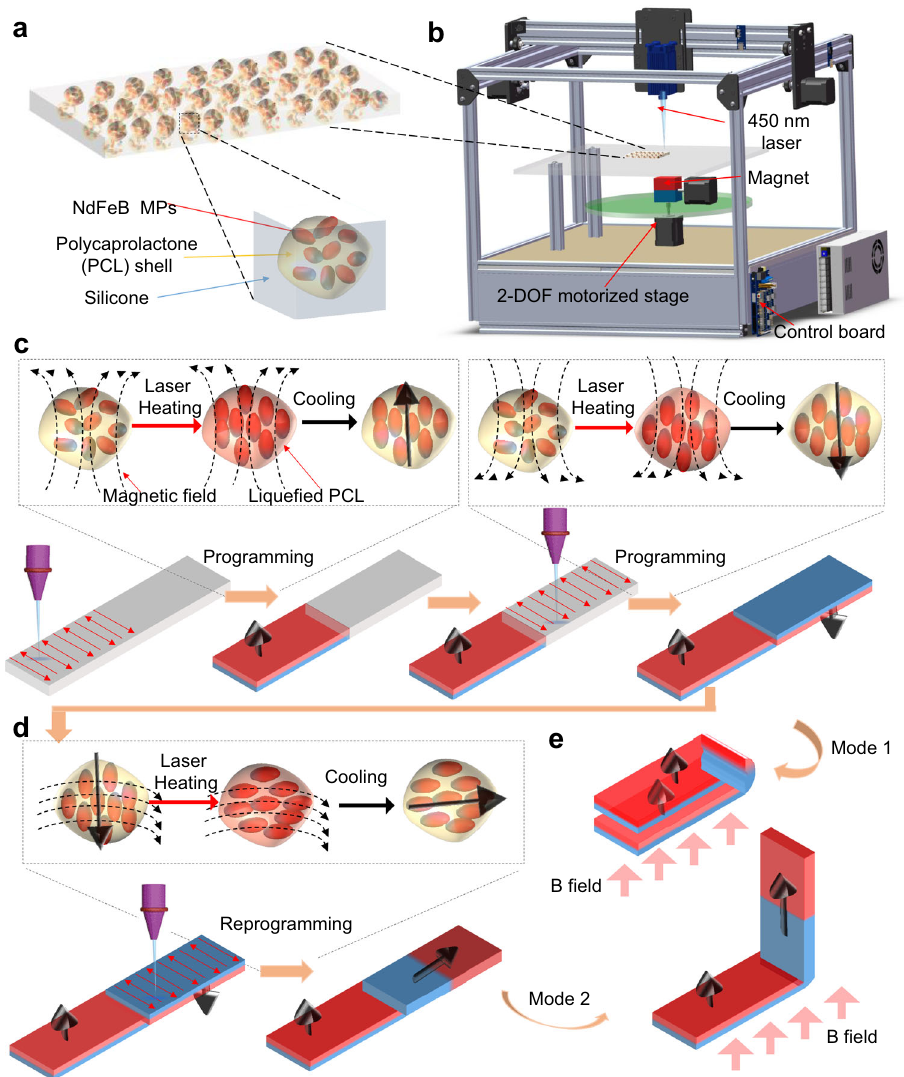
Fig. 1 System design and mechanism of reprogramming the magnetic anisotropy in MRSM fi lms by DLW. a Schematic showing the structure of a MRSM fi lm, which consists of silicone and magnetic NdFeB MPs wrapped by PCL shells. b Schematic of a customized DLW system for programming a magnetic anisotropy in a MRSM fi lm. c Schematic showing steps of programming a magnetic anisotropy in a MRSM fi lm. d Schematic showing steps of reprogramming a magnetic anisotropy in the same MRSM fi lm to the one shown in c . e Schematic showing mechanism of multiple shape transformation modes in a reprogrammable MRSM fi